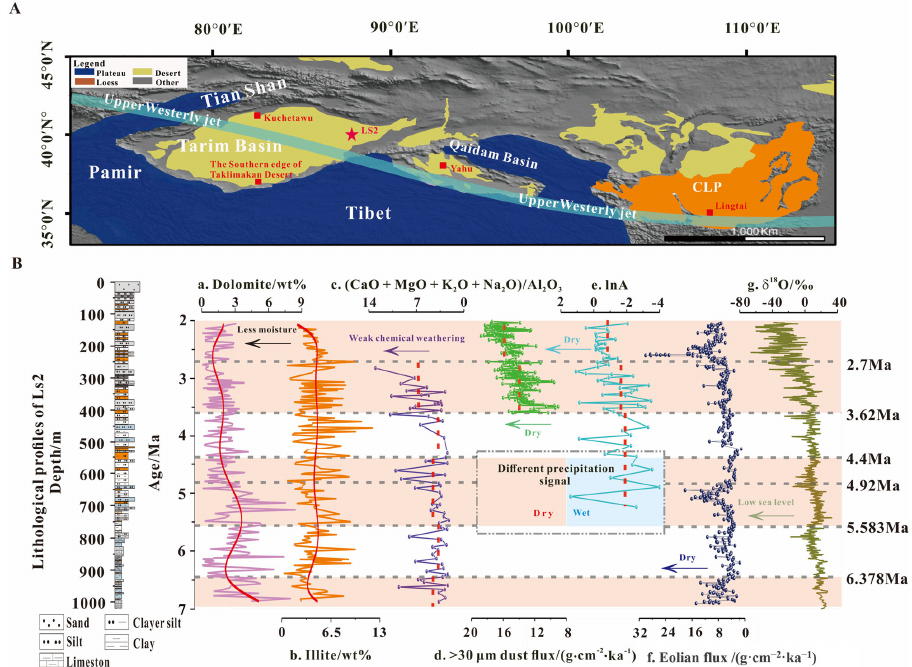
Figure 4. Comparison of climatic indices from different areas. ( A ) Map of different areas in the Asian interior, where climate is dominated by the westerlies (Modified from [47] ( B ) Correlation of minerals from drill core Ls2 in the eastern Tarim Basin (a, b: this study) with (c) weathering index (CaO + MgO + K 2 O + Na 2 O)/Al 2 O 3 from the Kuchetawu section, northern Tarim Basin [8] , (d) >30 μ m grain size of eolian flux in the loess core from southern margin of the Tarim basin [46] , (e) aridity index lnA from the Yahu section in the Qaidam basin [48] , (f) eolian flux from the Lingtai section, Chinese Loess Plateau [49] , and (g) global deep ‐ sea oxygen isotopes. The red area and the blue area represent intervals of relatively arid and humid climate, respectively.